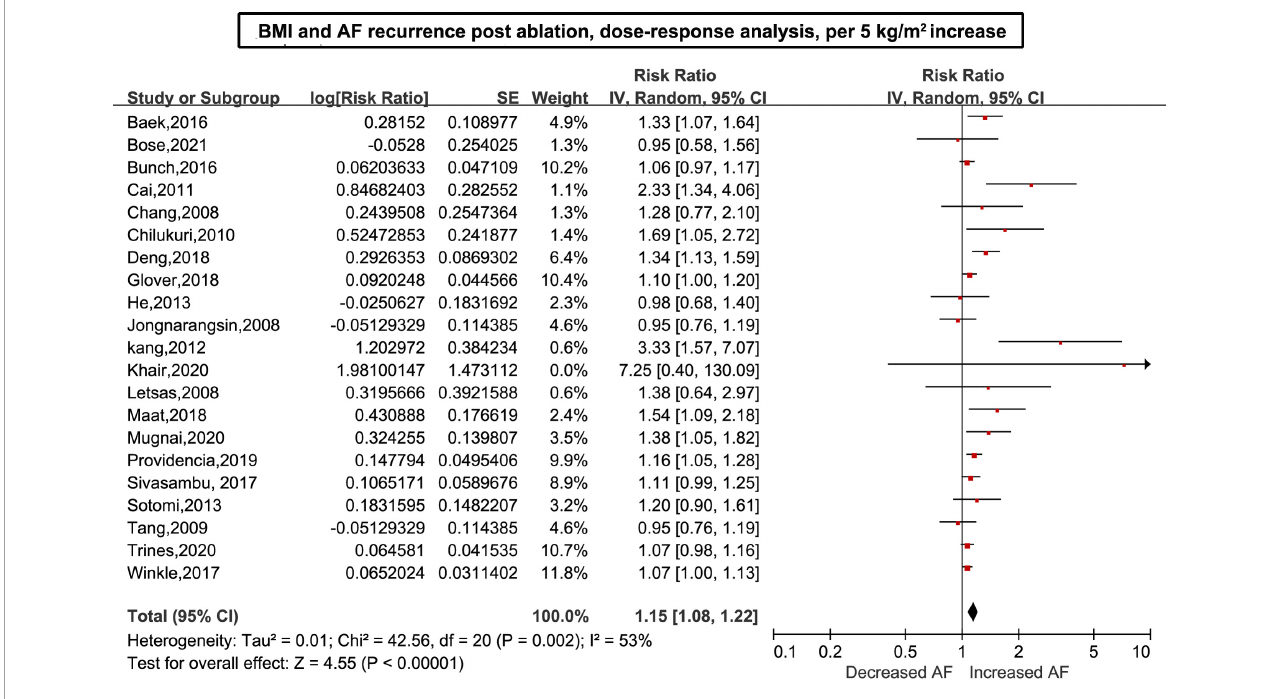
FIGURE2 Body mass index and atrial fibrillation recurrence in patients undergoing radiofrequency ablation based on a dose-response analysis, per 5 units.